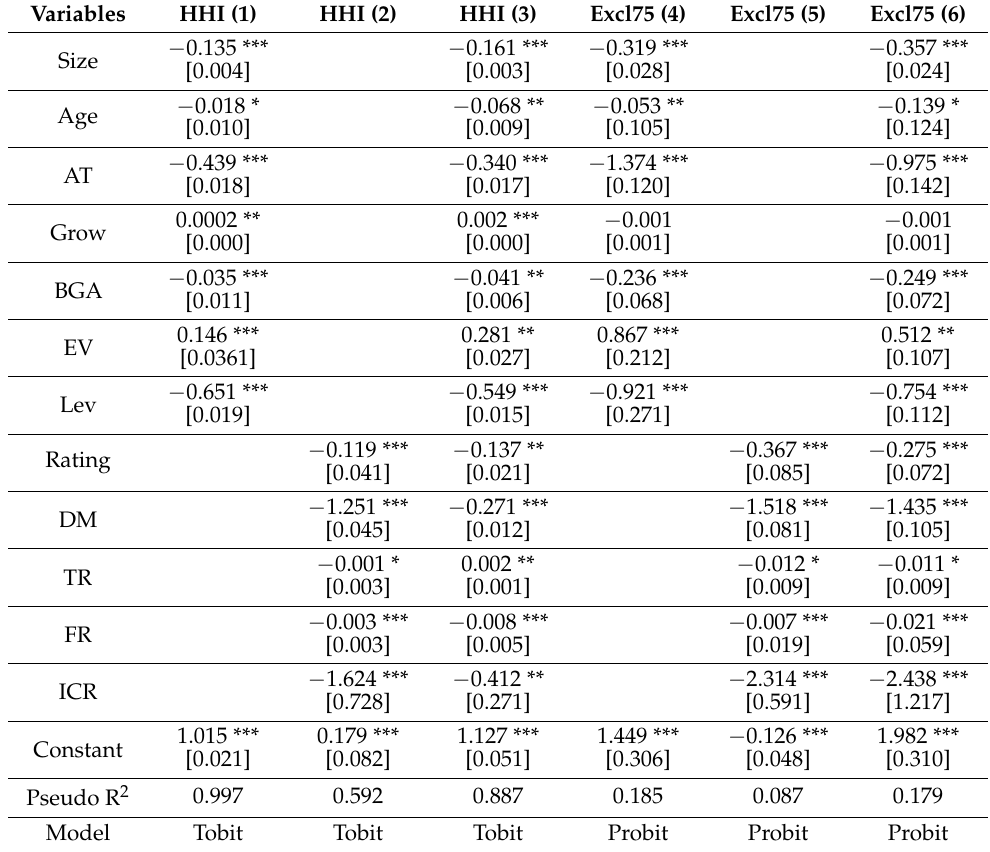
Table 7. Multivariate evidence on debt